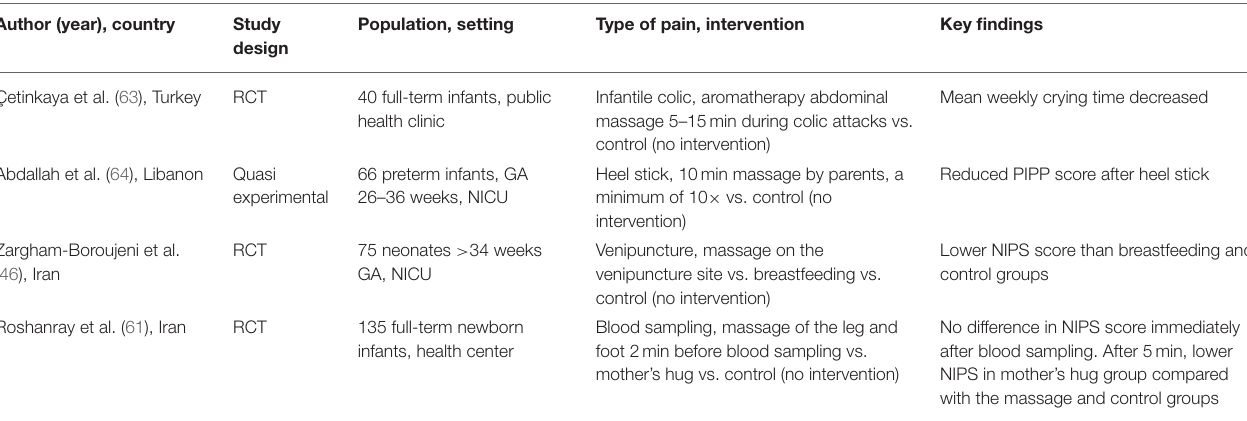
TABLE 5 | Evidence for parent-delivered interventions: